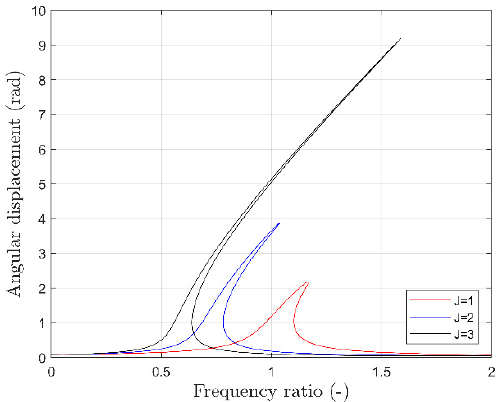
Figure 6. Comparison of frequency-response curves when varying the ( a ) friction damping coefficient (cid:2020) ∗ ( (cid:2009) ∗ = 0.1(cid:2033) (cid:2868)(cid:2870) , (cid:1856) ∗ = 0.05(cid:2033) (cid:2868) , (cid:2030) (cid:3036),(cid:3037) (cid:1869)(cid:3548) = 0.15 ) and ( b ) excitation amplitude (cid:2030) (cid:3036),(cid:3037) (cid:1869)(cid:3548) ( (cid:2009) ∗ = 0.1(cid:2033) (cid:2868)(cid:2870) ,(cid:1856) ∗ = 0.05(cid:2033) (cid:2868) ,(cid:2020) ∗ = 0 ).